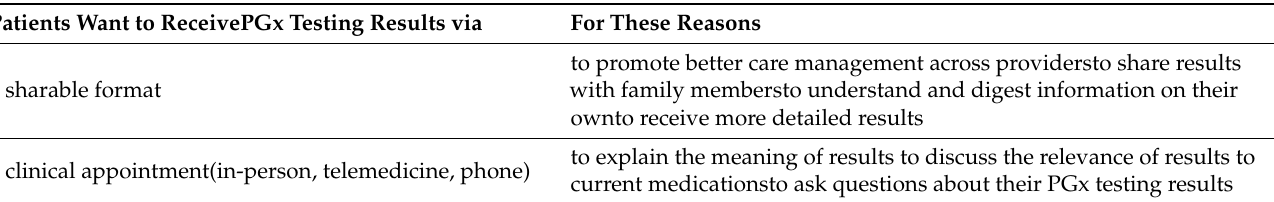
Table 4. Patients’ Preferences for Receiving PGx